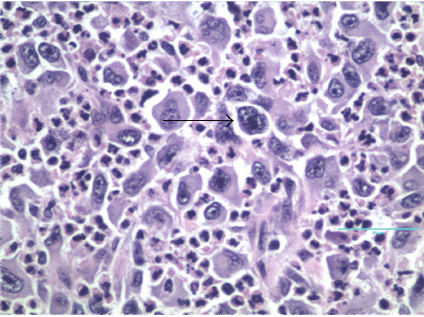
Figure 1: Gross specimen showing a section of skin with an ulcerative lesion (left) with necrotic tissue (right) that detached during resection.